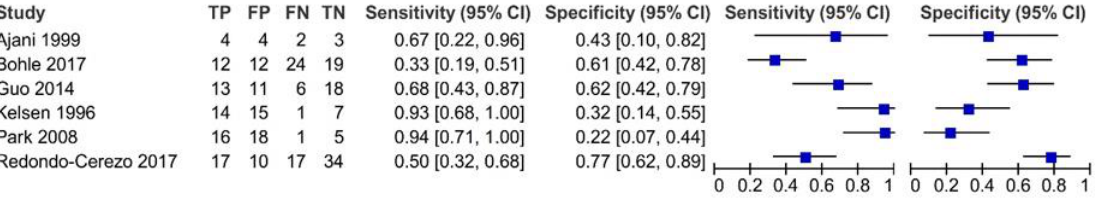
Figure 6. Forest plot for T3 restaging.